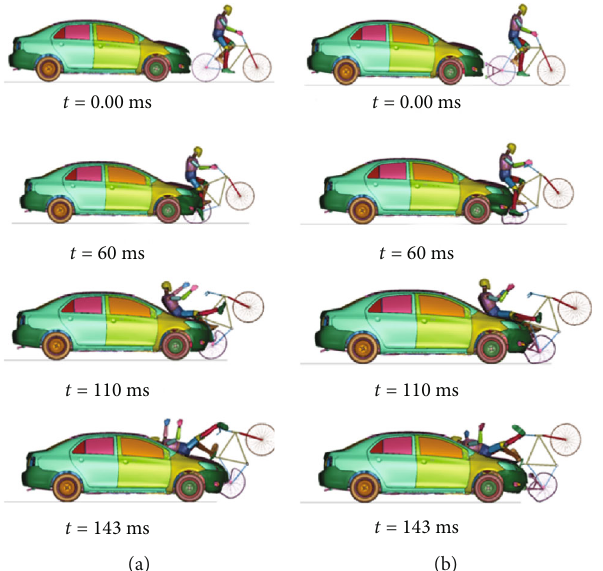
0.050.0100.0150.0200.0